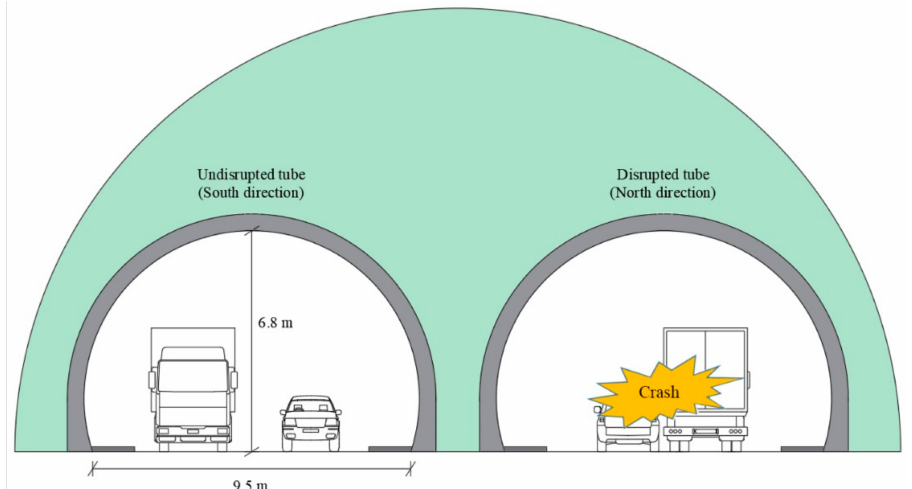
Figure 1. Cross-section of the twin-tube motorway tunnel